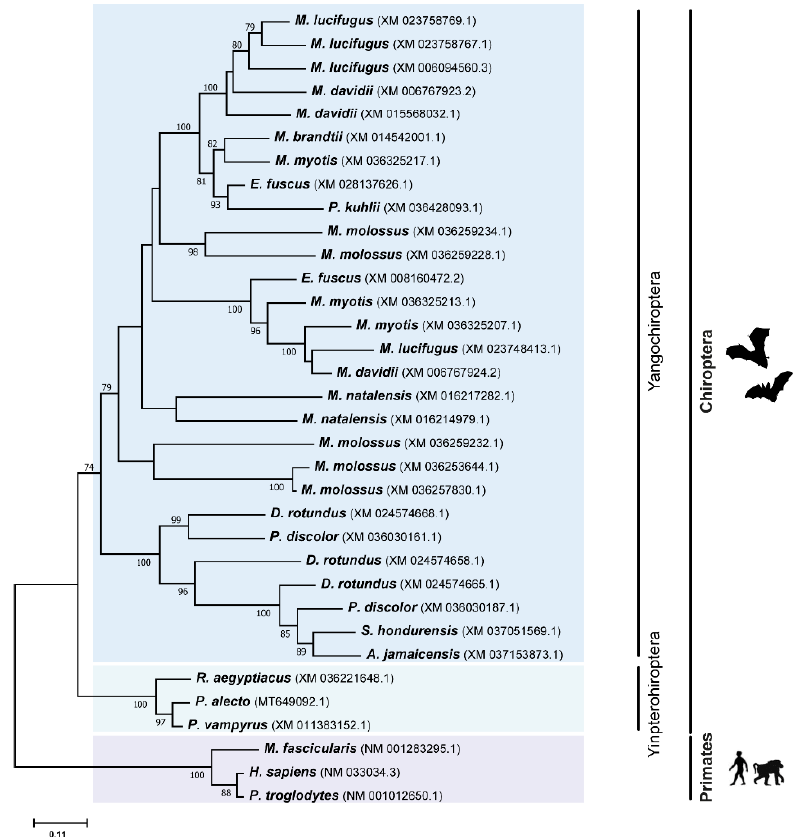
Figure 2. Phylogenetic analysis of TRIM5 protein in different Chiroptera species. The analyses were performed with 1000 generations and 1000 bootstrap searches. Bootstrap values (%) are indicated on the branches, and only bootstraps above 70% are shown.